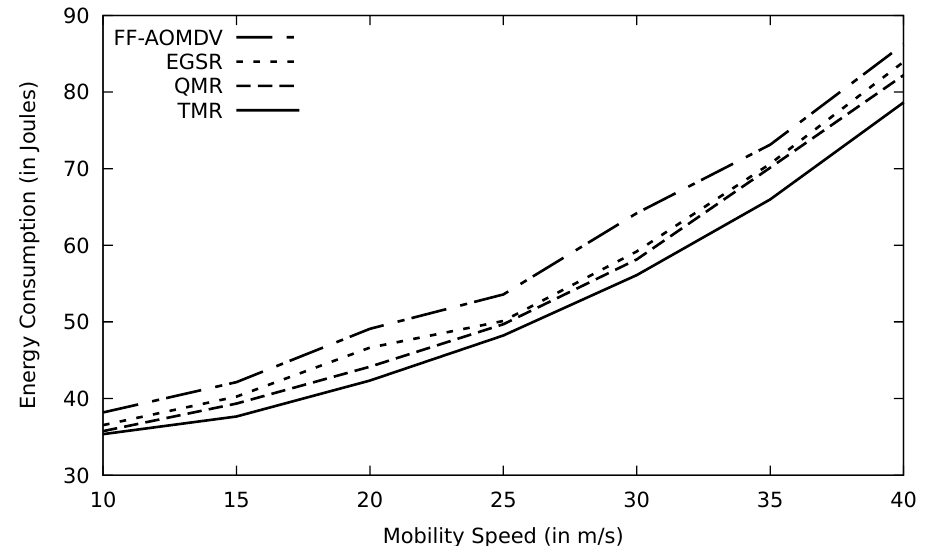
Figure 20. Comparison of FF-AOMDV, EGSR, QMR, and proposed protocol TMR for energy con- sumption with mobility speed.